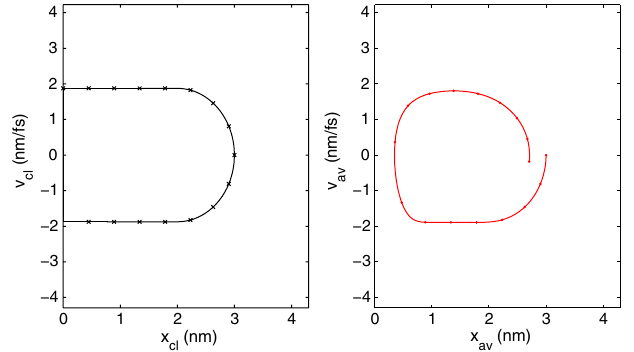
FIG. 2. Motion of a classical (left) and quantum (right) elec- tron in phase space. In both cases the initial position is 3 nm with no velocity. Points show time steps from 0 to T with steps of T= 16 , where T ¼ 3 : 8 fs is the natural period of the motion.